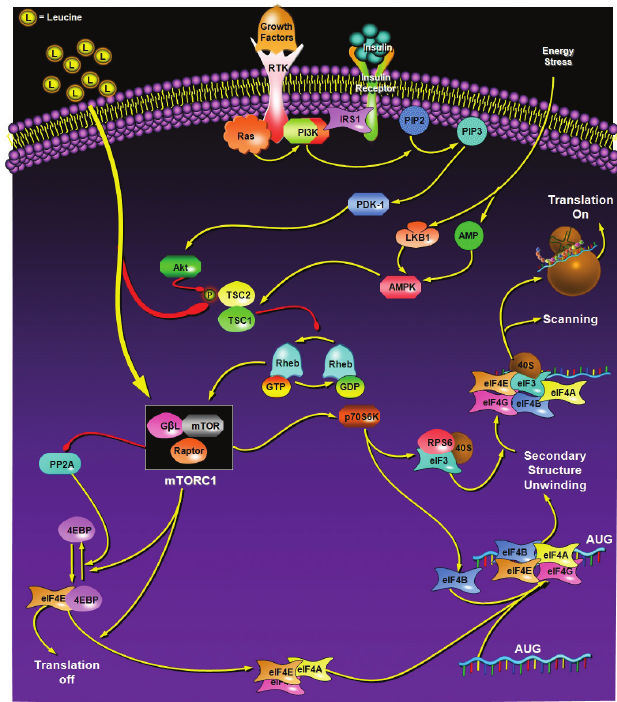
FIGURE 2 – Regulation of mTOR pathway by insulin and leucine. Adapted from Hinault et al.